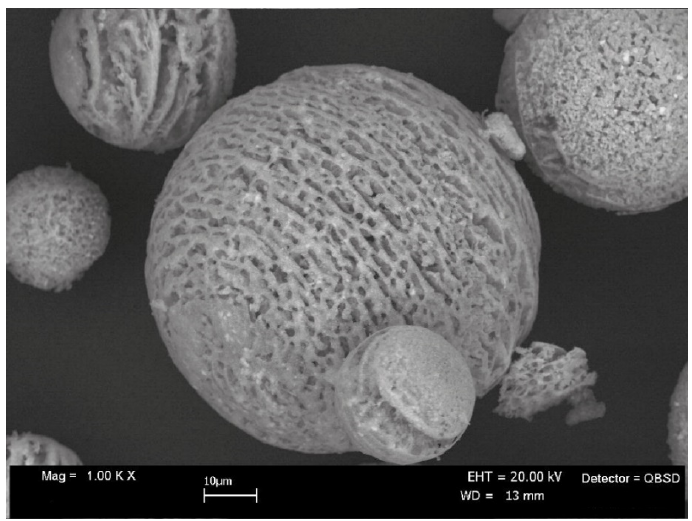
Figure 4. SEM micrograph of 60402Y powder prepared with freeze-dry